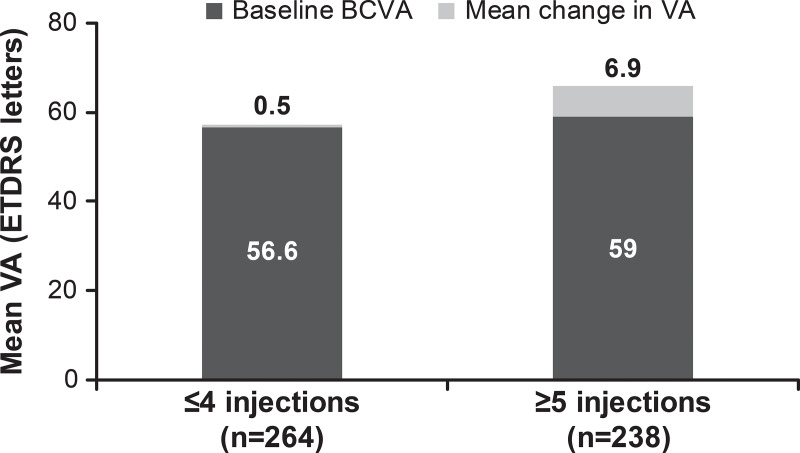
Mean change in visual acuity by injection frequency in treatment-naïve patients with DME (N = 502; primary treated eye set).Observed dataset for VA change. The primary treated eye set included all primary treated eyes in patients included in the safety set. The safety set consisted of patients in the enrolled set who were treated with at least one dose of ranibizumab during this study or prior to the start of the study and had at least one safety assessment after the first treatment. For treatment-naïve eyes, the date of first on-study injection with ranibizumab was considered the baseline date. For the 1-year time period, all patients with non-missing baseline VA and year 1 VA performed anywhere between Day 319 and Day 409 but who had been in the study for at least 365 days from baseline to last follow-up date were included in the analysis. DME, diabetic macular edema; ETDRS, Early Treatment Diabetic Retinopathy Study; VA, visual acuity.